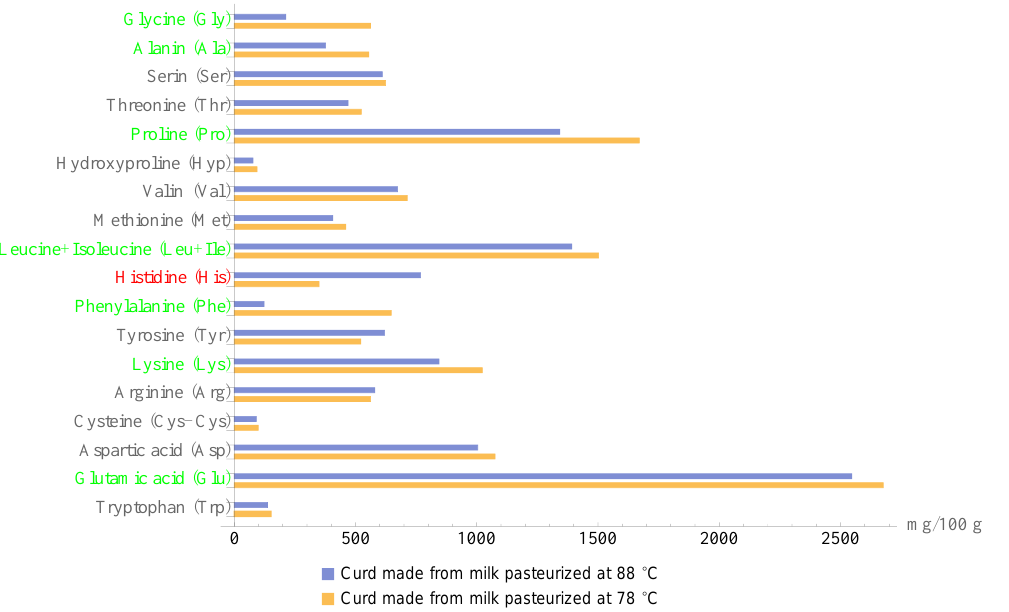
Figure 2. Amino acid composition of the acid curd samples made from the milk pasteurized at 78 ± 2°C and 88 ± 2 °C. Red: amino acids with content that was higher in the samples made from the milk pasteurized at 88 ± 2 °C, green: 78 ± 2 °C. Black: amino acids without statistically significant differ- ence in the content.